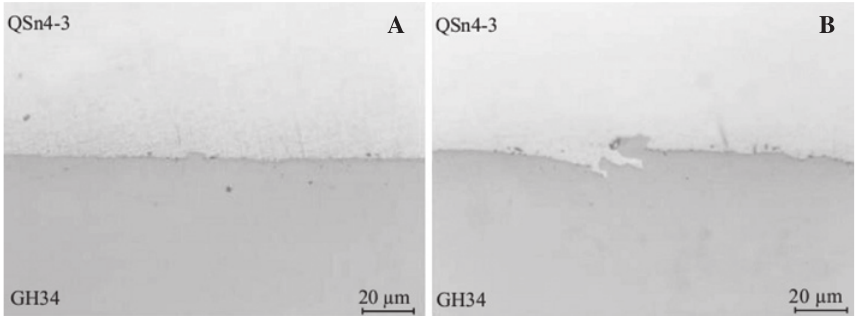
Figure 2 Interface microstructure of the joints bonded at 950 ° C, 10 MPa for (A) 1 h and (B) 3